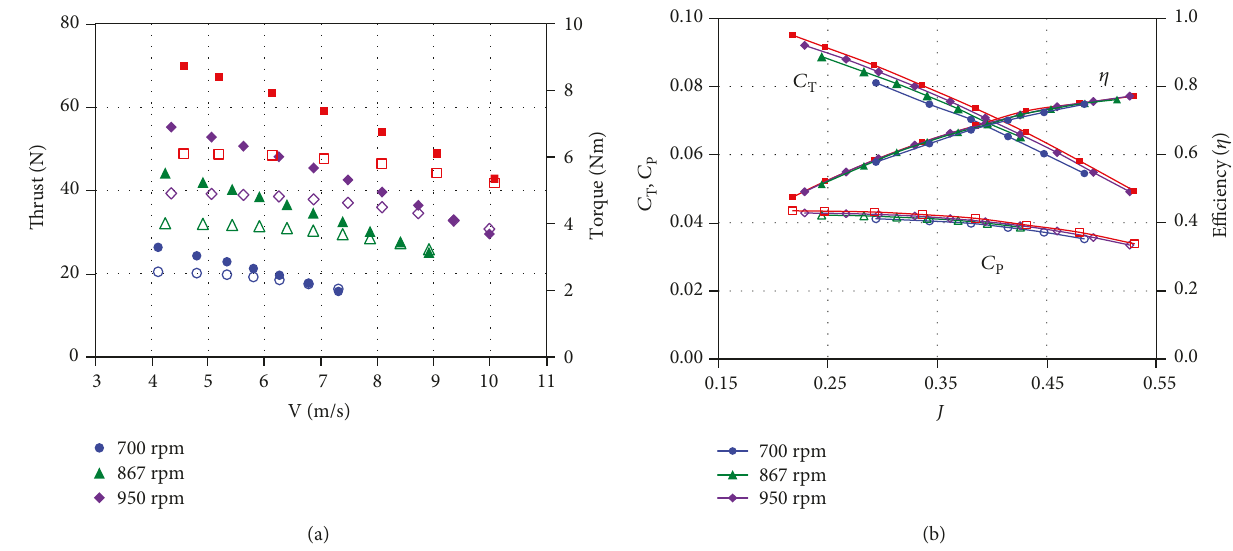
Figure 16: (a) Measured thrust and torque and (b) performance coe ffi